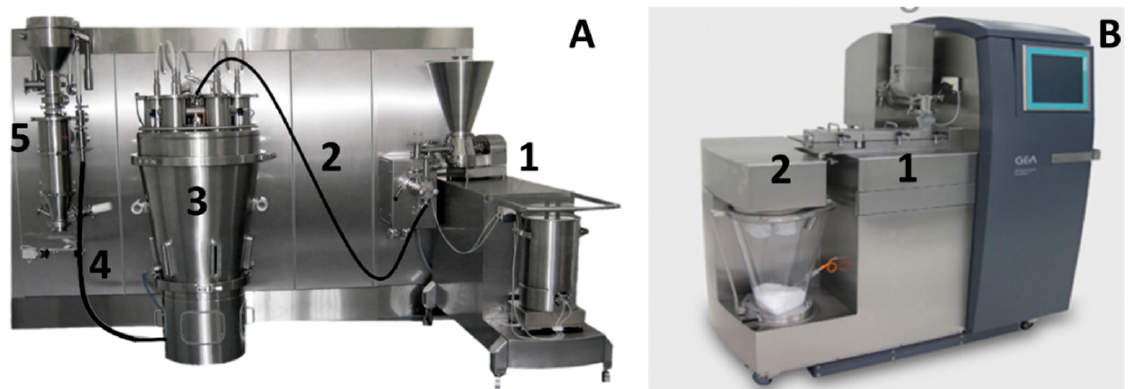
Figure 1. ConsiGma-25 line ( A ): twin-screw wet granulation module (1), wet transfer line (2), six-segmented fluid bed dryer (3), dry transfer line (4), and conditioning unit with mill (5). Laboratory ConsiGma-1 unit ( B ): twin-screw wet granulation module (1) and one-segmented fluid bed dryer (2).